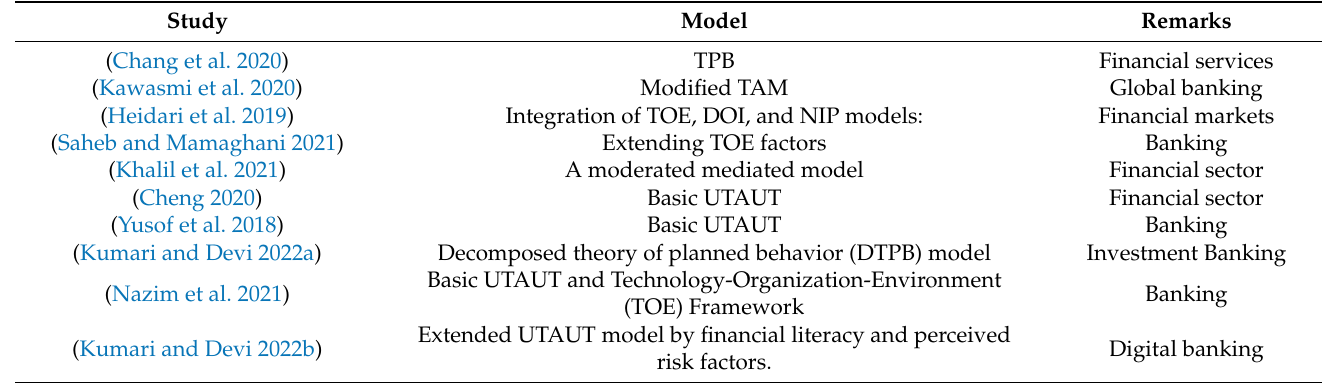
Table 1. UTAUT and its extension used for technology